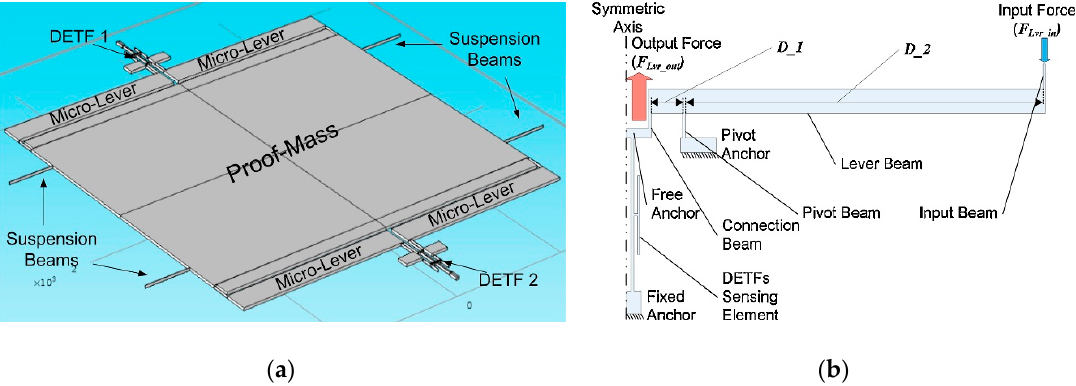
Figure 17. Schematic diagrams of the resonant MEMS accelerometer developed by Zou and Seshia at Cambridge University [101]: ( a ) the resonant MEMS accelerometer comprising four single stage force amplification mechanisms; ( b ) a single-stage force amplification mechanism.